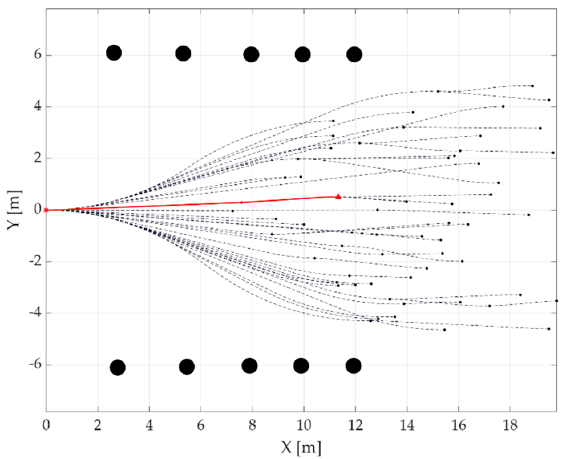
Figure 8. Generated path (solid, red) and search tree expansion (dashed, black) for a straight road portion, with obstacles (black, dots), starting vehicle position (red asterisk) and goal point (red triangle).